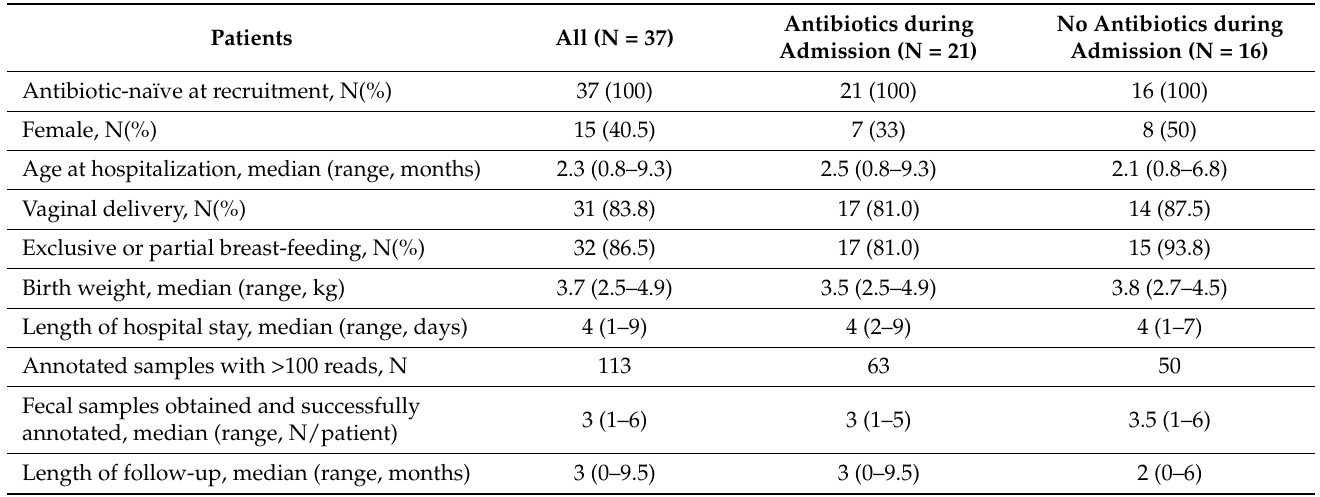
Table 2. Patient characteristics stratified by control and antibiotic